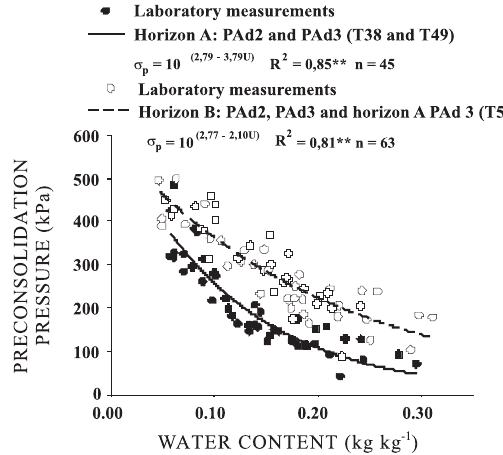
Figure 2. Bearing capacity models of the PAd2 and PAd3, under eucalypt plantation for the A and B Table 3. Bulk density (Mg m -3 ) determined in the wood load position and before and after harvest operations in two Ultisols (PAd2 and PAd3), in the A and B horizons